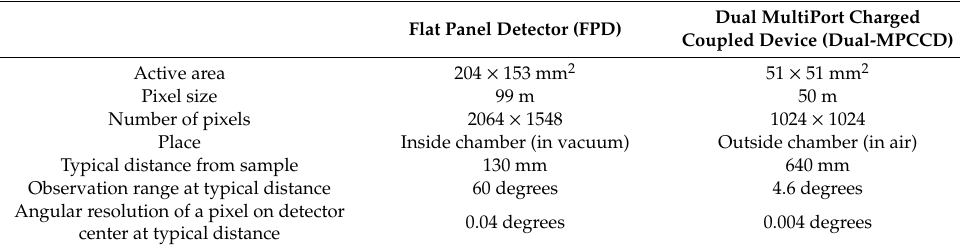
Table 1. Detectors for XRD